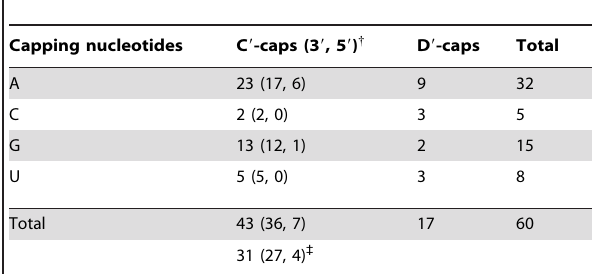
Table 2. Diversity of unpaired capping nucleotides.